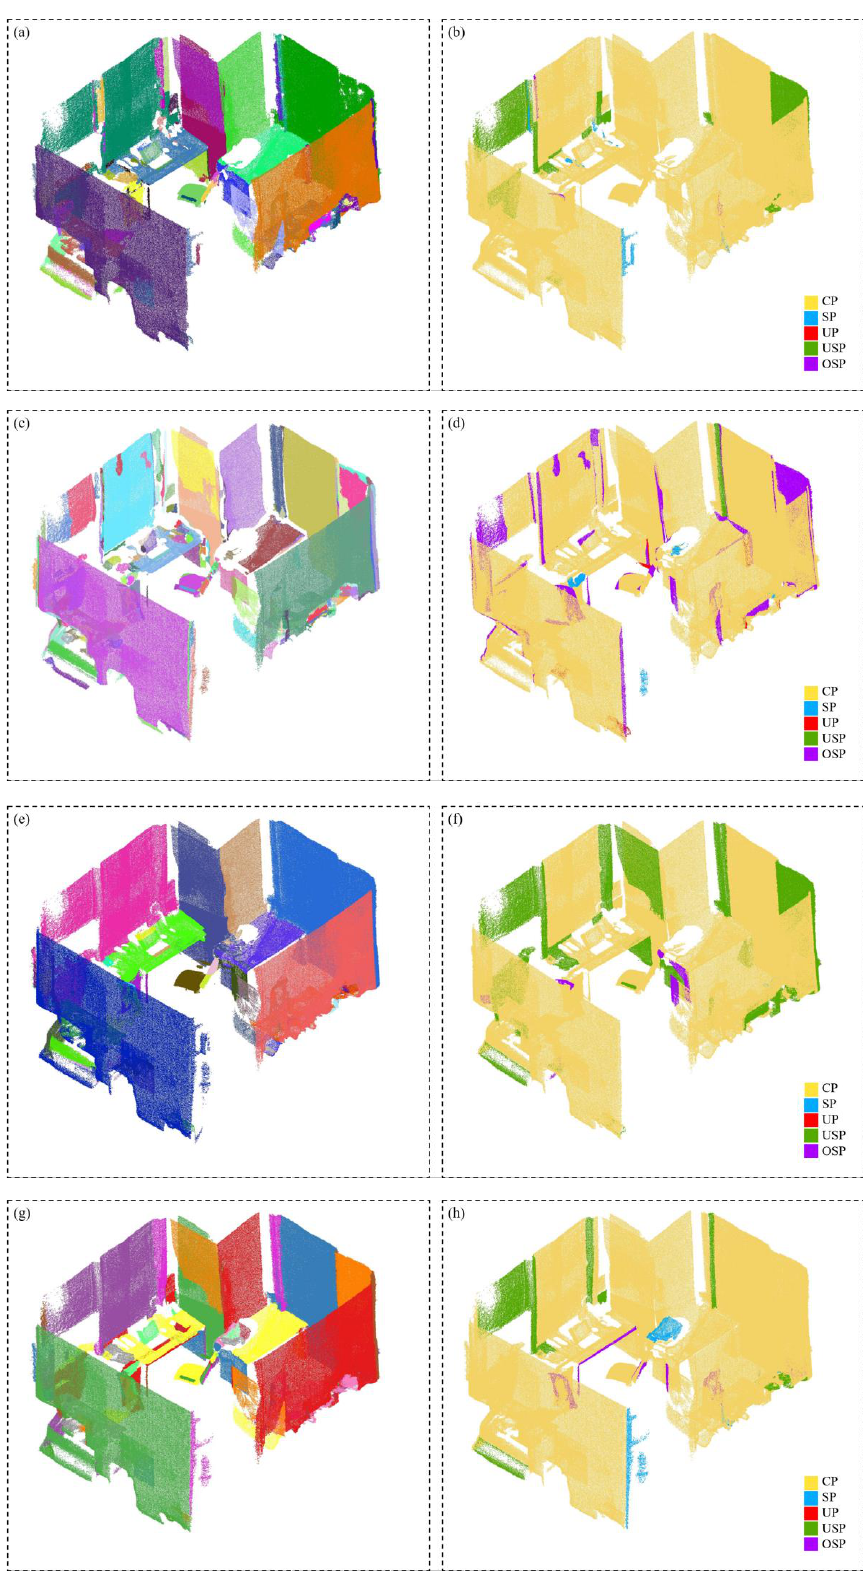
Figure 20. Comparison of the plane-segmentation results of the Office dataset: ( a , b ) proposed method and the main differences from ground truth, ( c , d ) RG and the main differences from ground truth, ( e , f ) efficient RANSAC and the main differences from ground truth, and ( g , h ) G-L 0 and the main differences from ground truth.